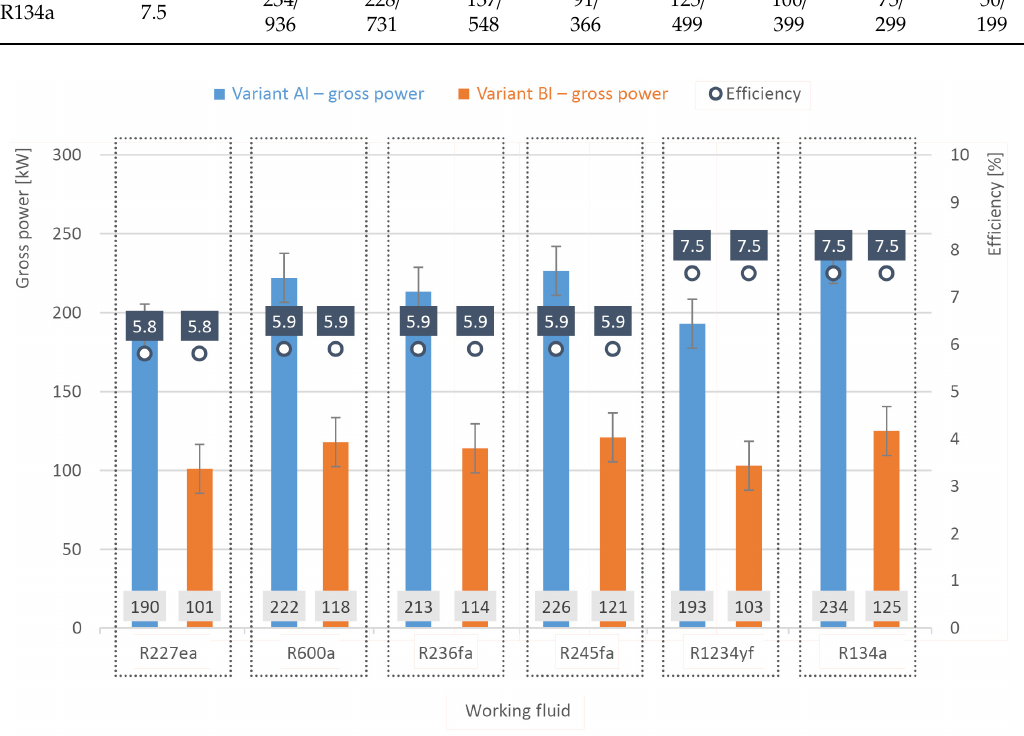
Figure 5. Comparison of results obtained for gross power and efficiency in the AI and BI variants using ORC technology.